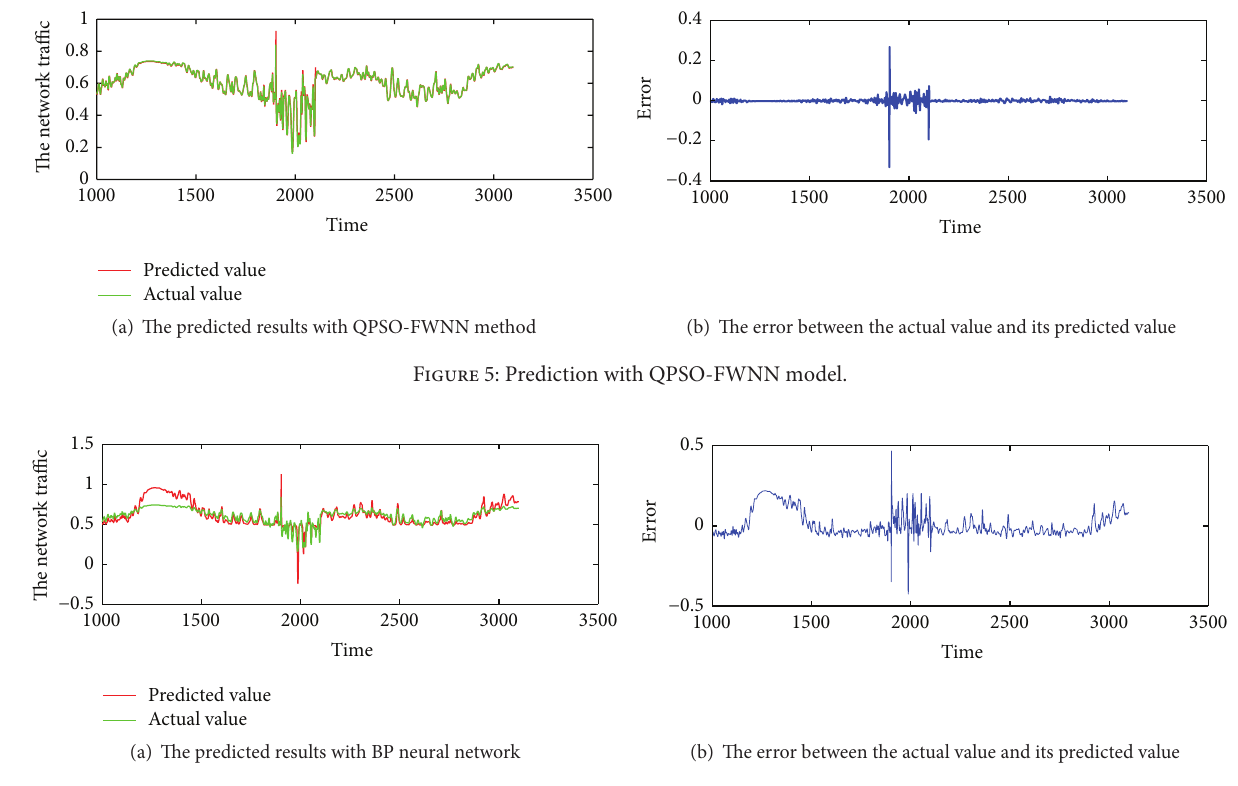
Figure 6: Prediction results with BP neural network.